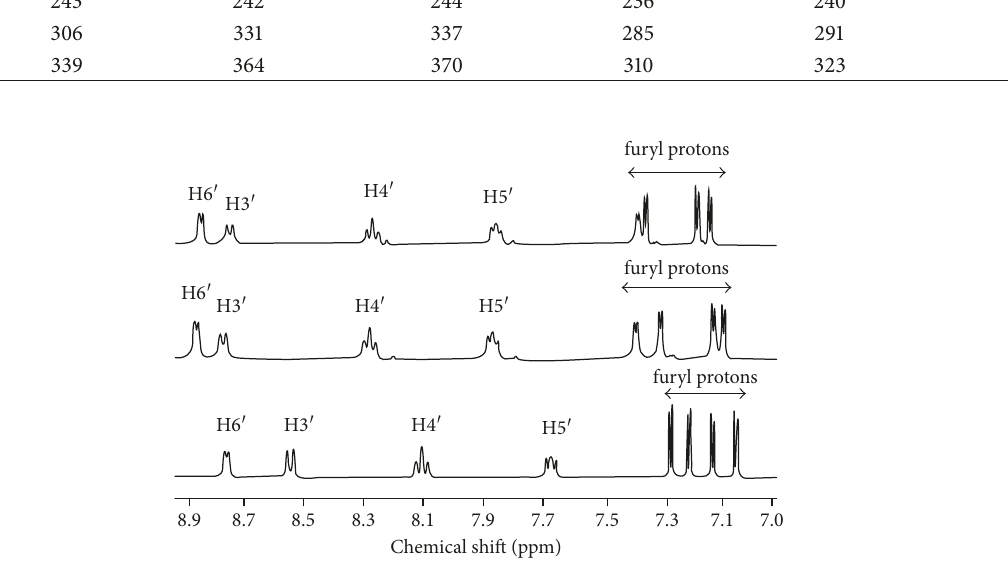
Figure 3: 1 H NMR spectrum of ferene (bottom) and complexes 1 (middle) and 2 (top).